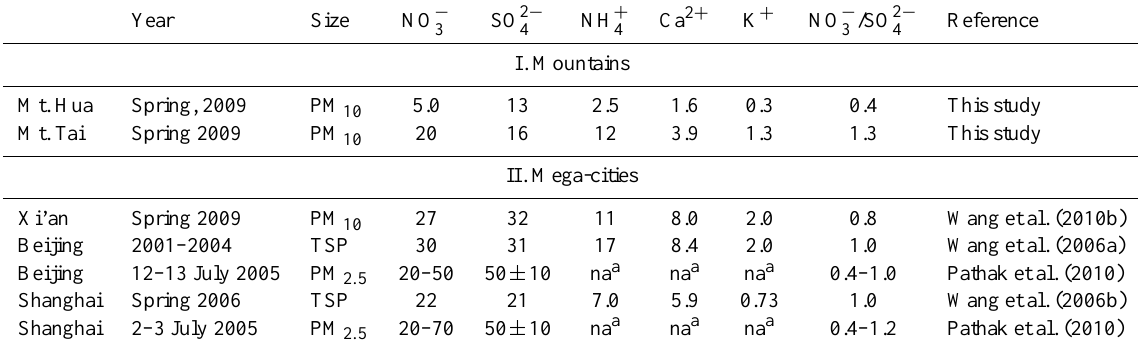
Table 5. Concentrations of inorganic ions in the mountain and urban atmosphere over China, µgm − 3 .